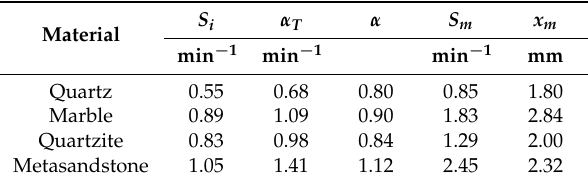
Table 5. Breakage rate parameters for all materials